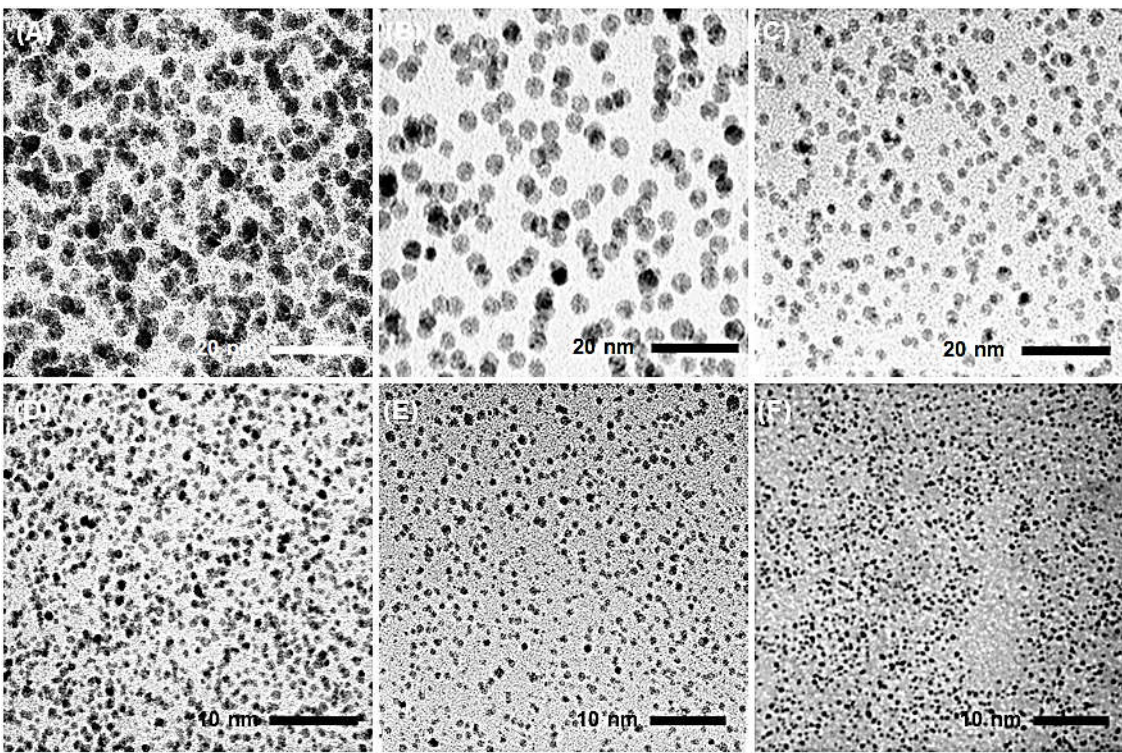
Figure 4. TEM images of AgNPs generated by the hydrazine-reduction of AgNO 3 in different BAIILs-based microemulsions: ( A ) 3a, ( B ) 3b, ( C ) 3c, ( D ) 3d, ( E ) 3e, and ( F ) 3f.